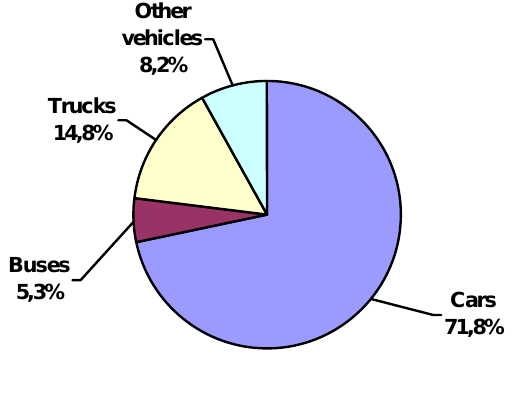
Figure 2. Shares of indirect energy associated with manufacturing, service and scrapping of vehicles registered in